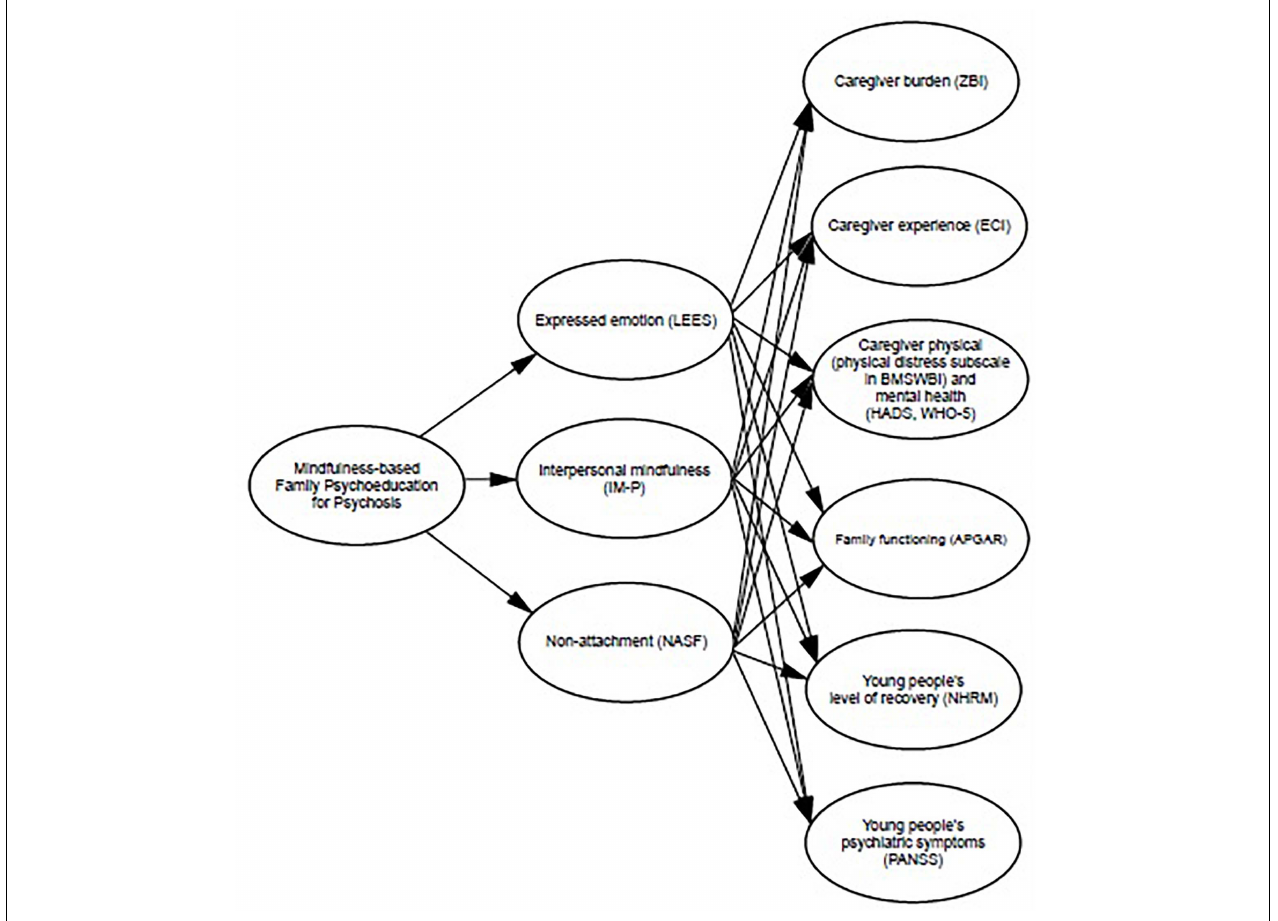
FIGURE 2 | Mediation